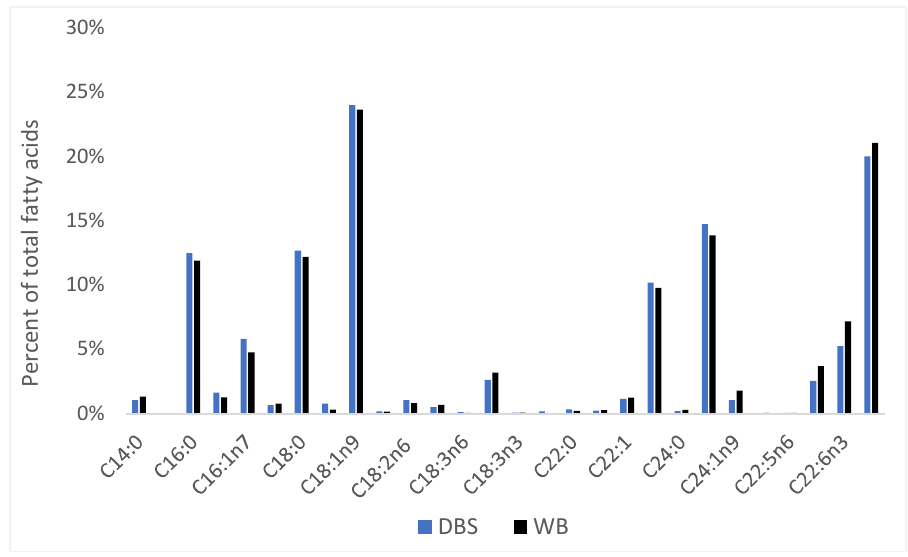
Figure 5. Mean percent of dried blood spot (DBS) FA composition compared with WB from 4 OBBs analyzed during 2017 SWC pilot study.